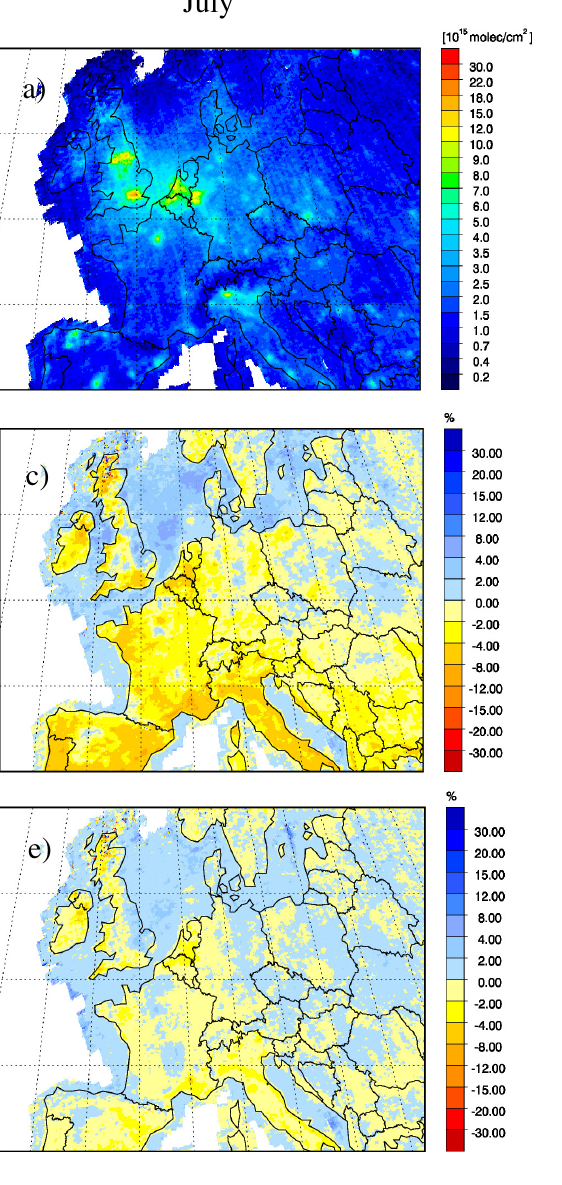
Fig. 10. Mean NO 2 VTCs averaged over 2006 and 2007 retrieved with full BRDF surface treatment for (a) July and (b) November. Relative differences (from NO BRDF ) in mean values when the surface is treated as Lambertian, assuming the BRF as albedo for July (c) and 2 Fig. 10: Mean NO VTCs averaged over 2006 and 2007 retrieved with full BRDF surface November (d) , and the black-sky albedo (as Lambertian input) for July (e) and November (f) 2 treatment for (a) July and (b) November. Relative differences (from NO 2BRDF ) in mean values